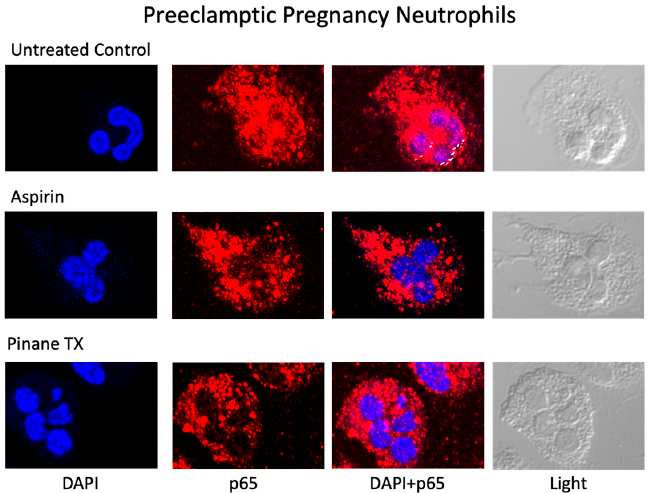
Figure 4. Confocal images of preeclamptic pregnancy neutrophils. Red fluorescence, the p65 subunit of NF- κ B; DAPI blue location of nucleus. x63 lens.